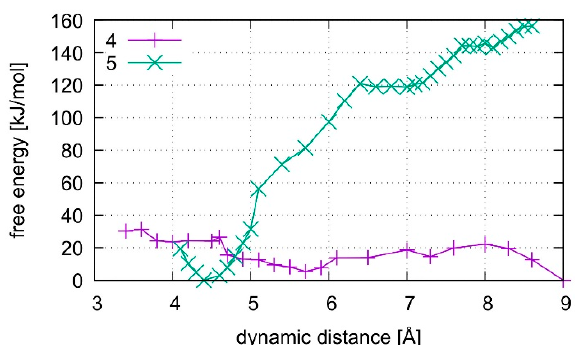
Figure 18. Comparison of the dissociation free energy in liquid water for the isolated T : ε A base pair where base pair 4 does not contain any Hg(II) ions whereas structure 5 is the dinuclear Hg(II)-mediated base pair. The introduction of Hg(II) leads to the formation of a metal-mediated base pair, whereas the Hg(II)-free base pair dissociates without the need of further energy.